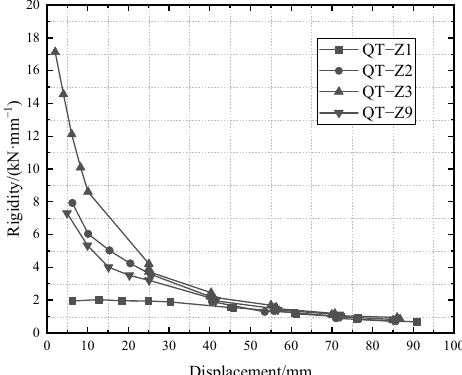
15 of 19 Figure 18. Skeleton curves. 4.3. Stiffness Degradation Curves The stiffness of the specimen decreases with the increase of the number of load cycles and displacement. Following regulation [21], stiffness degradation curves are used to represent the stiffness at different times. Figure 19 shows that the stiffness degradation curves of all the samples were smooth. Since QT − Z1 had no thin steel plates or RPUF, stiffness in the early stages is low, and the stiffness degradation rate is slow. The initial stiffness of QT − Z3 is the largest, eight times that of QT − Z1. However, the stiffness degradation rate of QT − Z1 is the fastest in the early stages, due to the failure of the thin steel plates and RPUF. The stiffness degradation curves of QT − Z2 and QT − Z9 are not